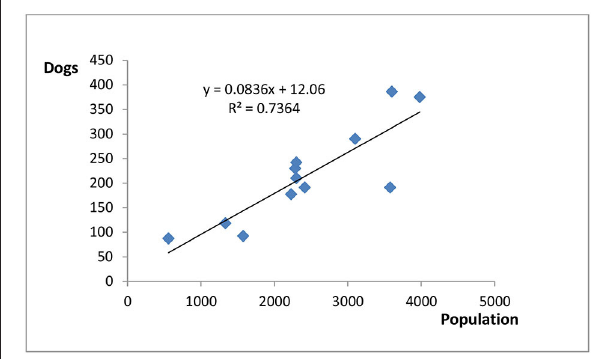
TABLE 4 | Collated results of dog questionnaire survey conducted in 12 selected villages, Jiading district, Shanghai. Township